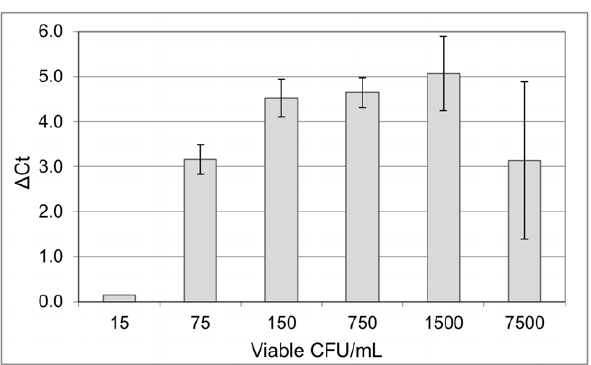
Figure 5. Ratiometric pre-rRNA analysis of A.baumannii cells in serum by using a rapid semi-automated approach. Serum- incubated cells were plated to quantify viable CFU/mL, then serially diluted in serum. Viable CFU/mL values (X-axis) were subsequently calculated from plating results. To initiate nutritional stimulation, dilutions in serum were further diluted 1:10 into TSB or PBS (stimulated and non-stimulated, respectively). After 90 minutes, pre-rRNA was quantified by one-step probe-based q-RT-PCR as described in text. Values are means and SDs of D Ct values (non-stimulated minus stimulated) from two replicates of each dilution. Control samples with no bacteria (0 CFU/mL) yielded no RT-qPCR results, and therefore could not be plotted as D Ct values. Reaction efficiency could not be calculated for this experiment, because no standard curve was used. A replicate experiment (Figure S3) yielded similar results, showing a limit of detection of # 56 viable CFU/mL.